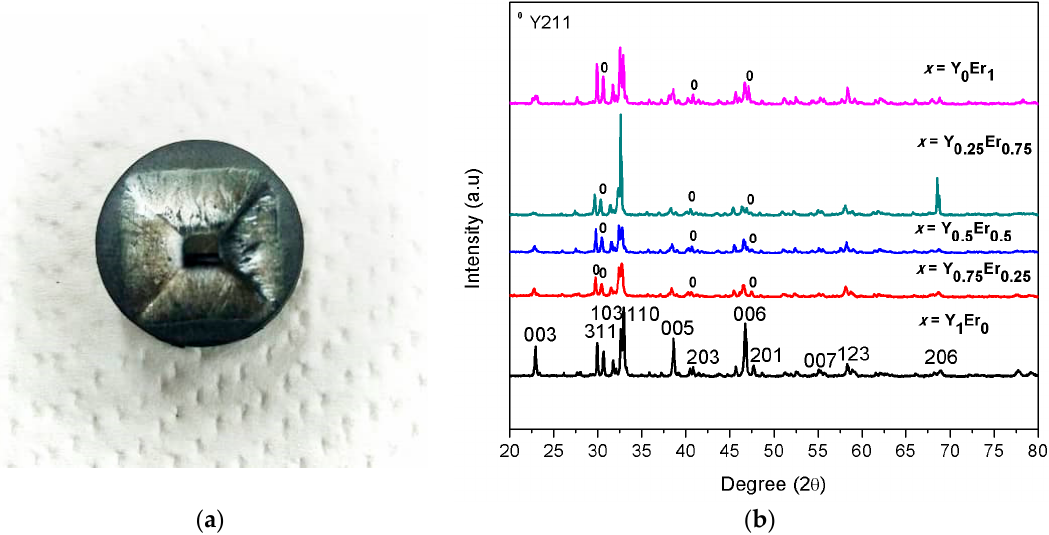
Figure 3. ( a ) The top view of bulk Y123 samples shows that faceted lines were observed indicating the perfect growth of Y123 single grain. ( b ) X-ray diffraction patterns in the range of 2 θ : 20 ◦ –80 ◦ for the samples.